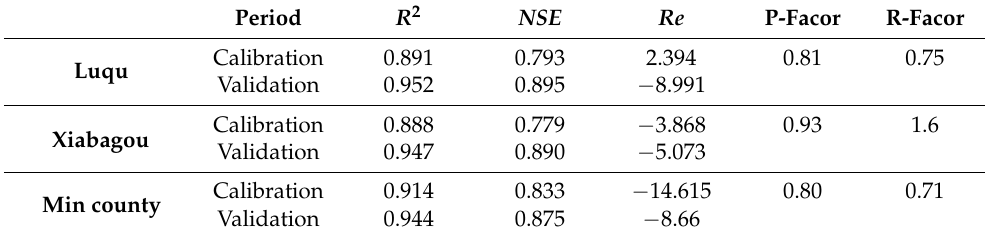
Table 5. Evaluation of runoff simulation results using gage